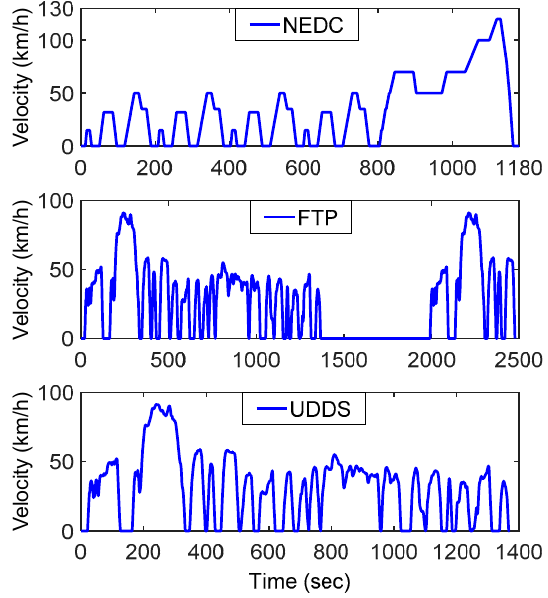
Figure 14. Standard driving cycles.